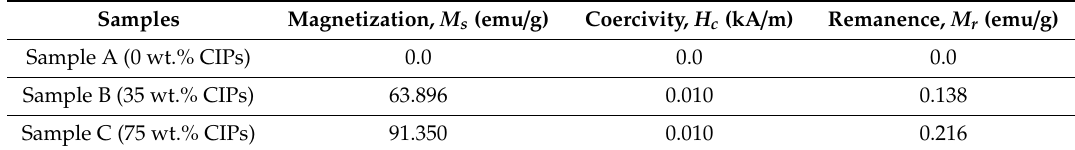
Figure 5. Magnetization curve of MR foam with different concentrations of CIPs. Table 3. Comparison of magnetic properties of MR foam with different concentrations of CIPs.